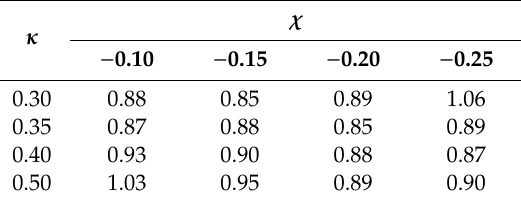
Table 2. Values of β Dis , NSAS / β Dis , CIS